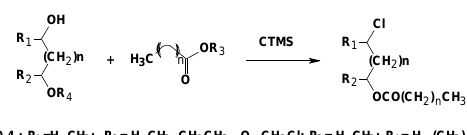
Figure 4. Synthesis of chlorohydrin ester, using carboxyl derivatives, glycerol and CTMS as reagents.